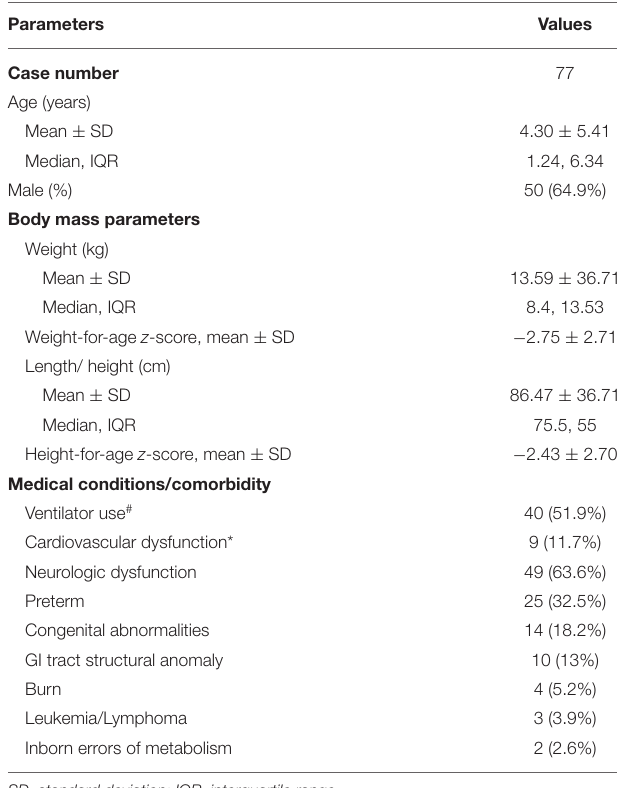
TABLE 1 | Patient demographics in patients with nasoenteric (NE) tube feeding.